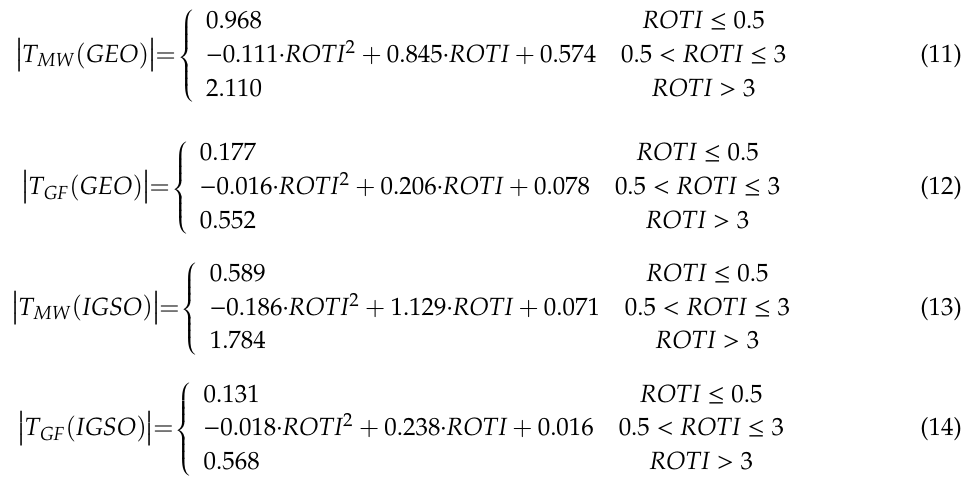
Figure 8. Statistical characteristics of ∆𝑁 (cid:3014)(cid:3024) and ∆𝛷 (cid:3008)(cid:3007) for GEO satellites data when 0.975 < ROTI ≤ Statistical characteristics of ∆ N MW and ∆Φ GF for GEO satellites data when